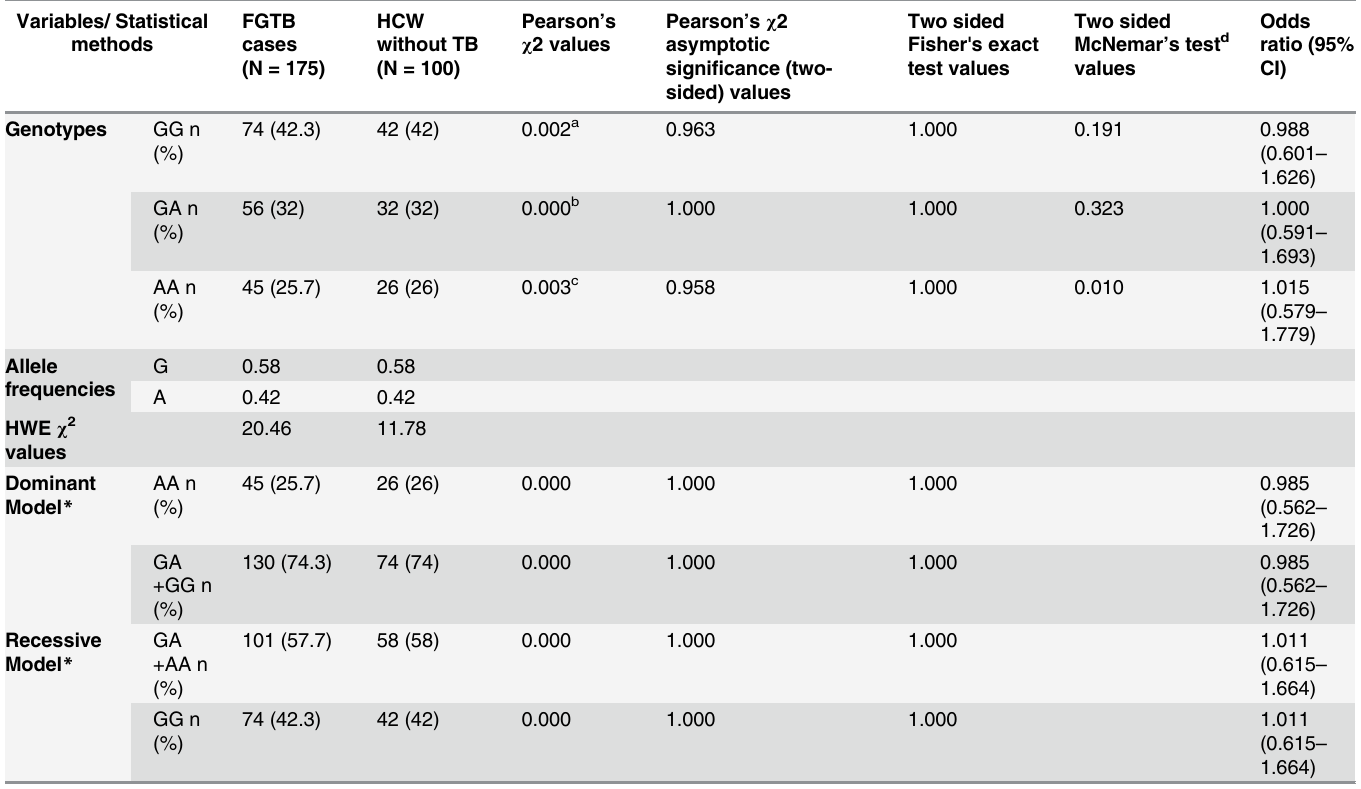
Table 7. The genotype distribution of the TLR2 (2258G/A) gene polymorphism among infertile women with FGTB and HCW without TB. Variables/ Statistical